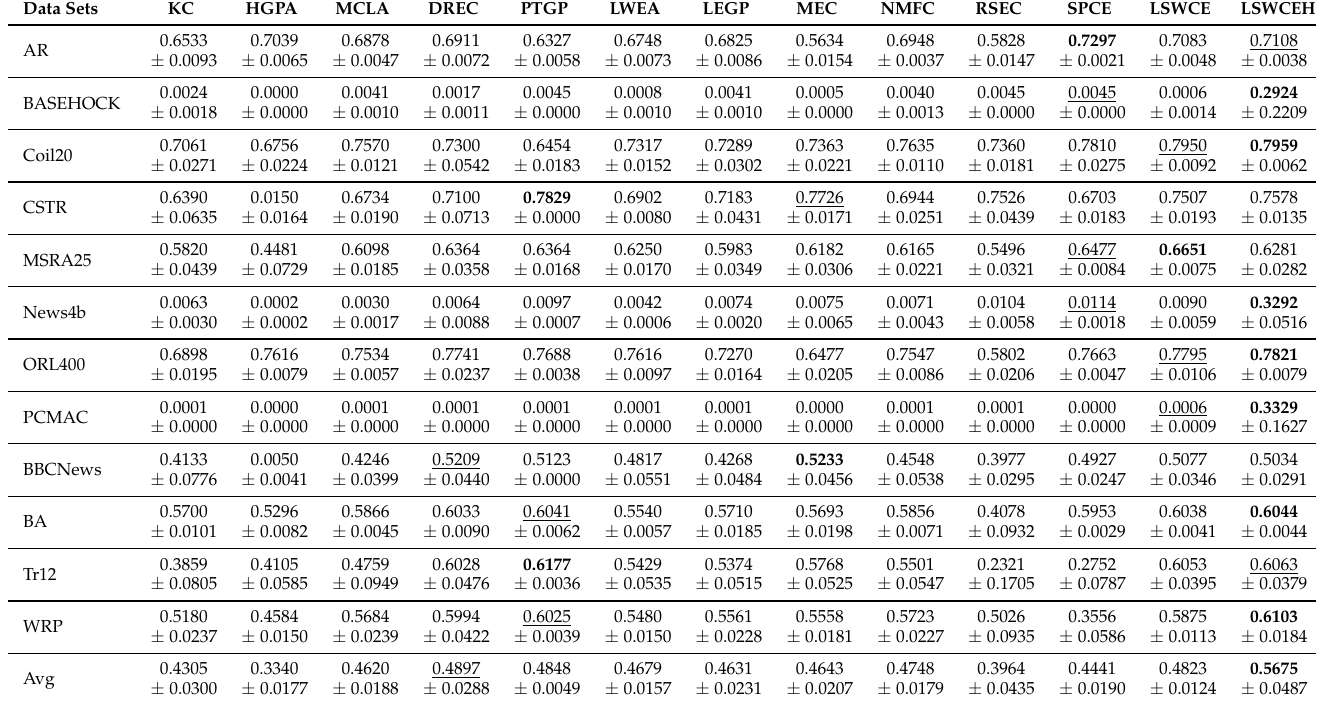
Table 4. Clustering results measured by the NMI of the compared